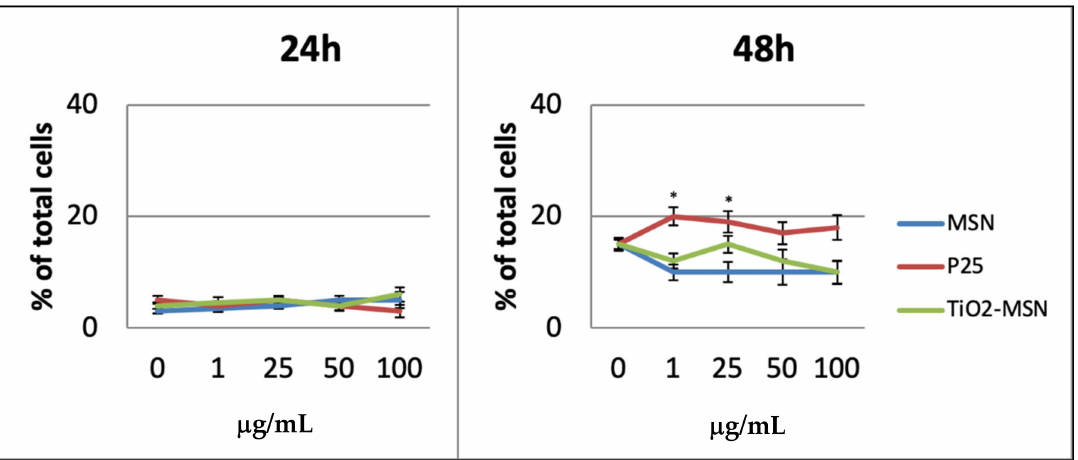
Figure 5. Necrosis detection by propidium iodide staining. Significance values: * p < 0.05; error bars represent the standard error of the